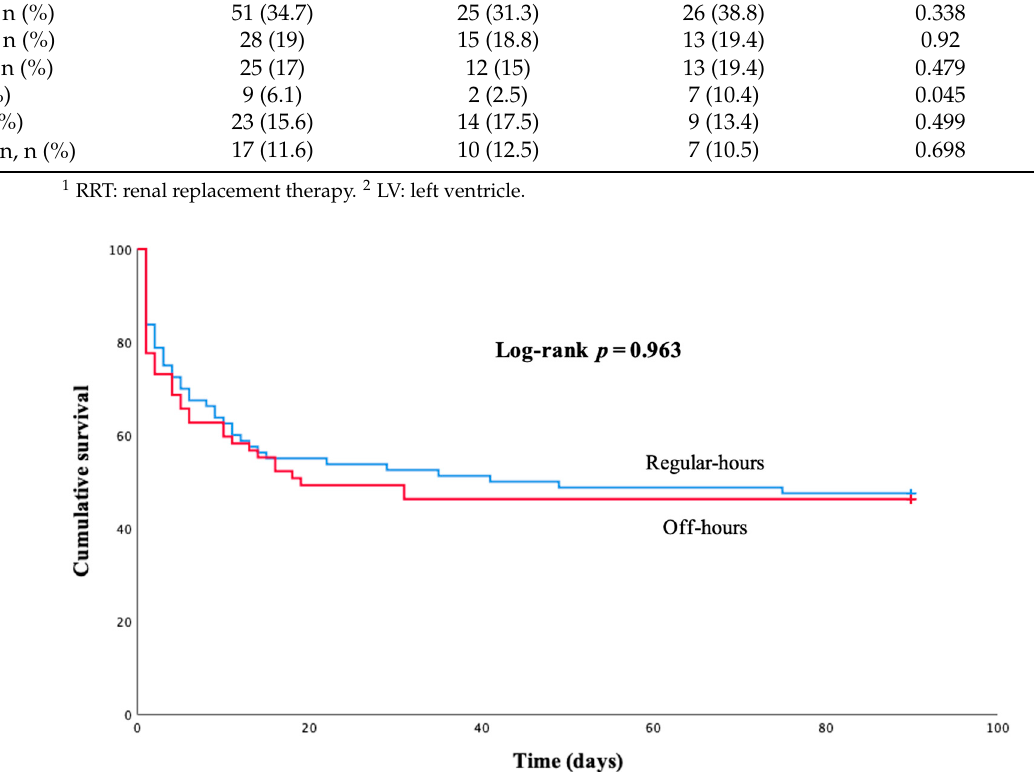
Figure 4. Kaplan–Meier survival curve for 90-day follow-up according to the moment of venoarterial extracorporeal membrane oxygenation implantation. Log-rank p = 0.963.